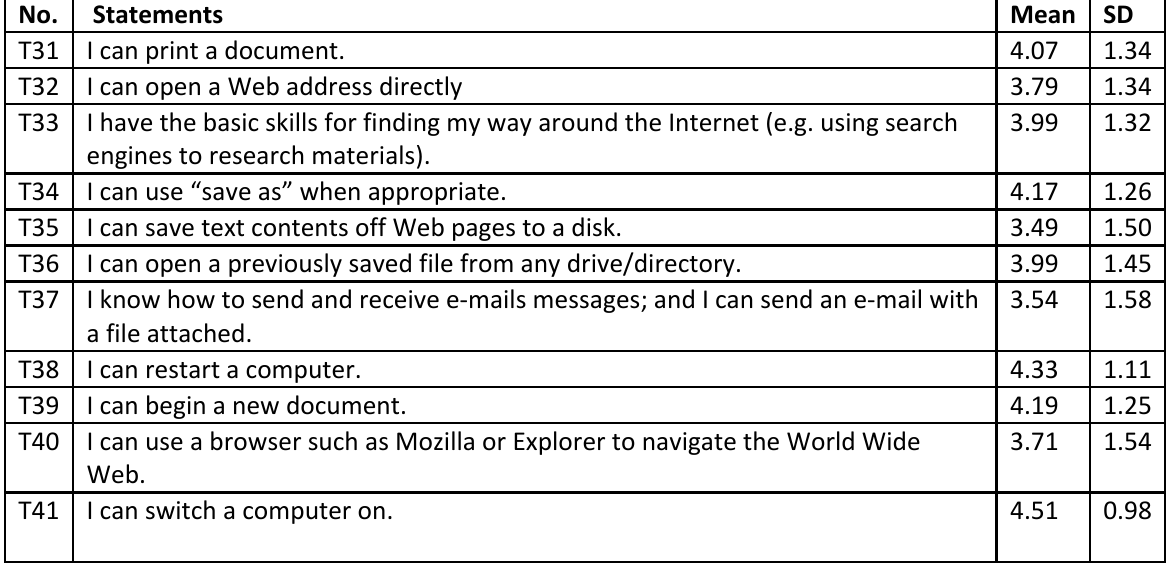
Table 2: Means and Standard Deviations in the Technical competency (N= 72)